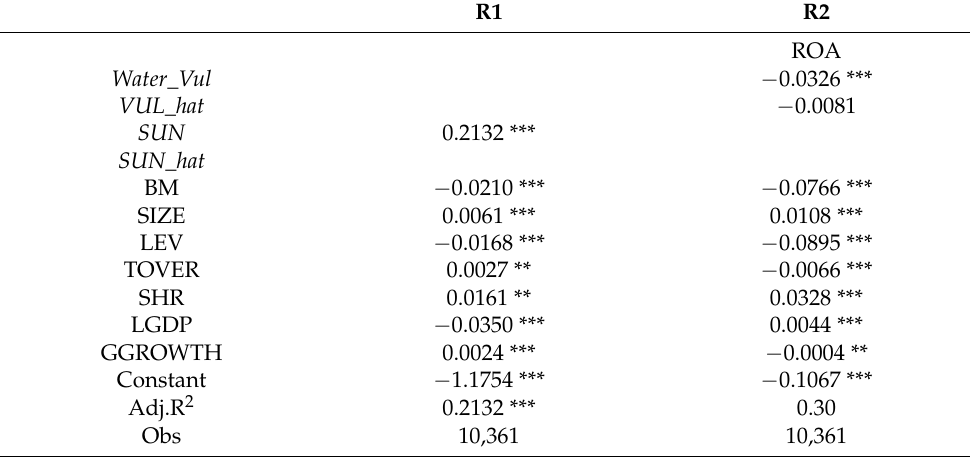
Table 5. Endogeneity